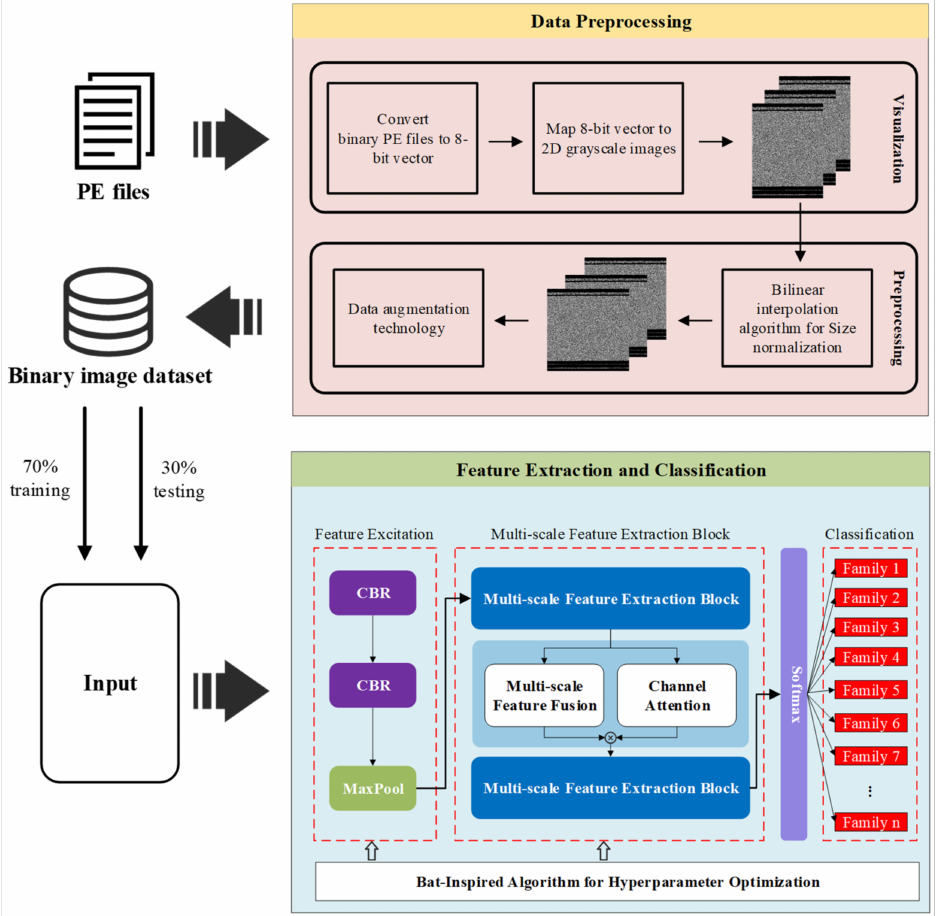
Figure 1. Overall structure of the proposed malware classification